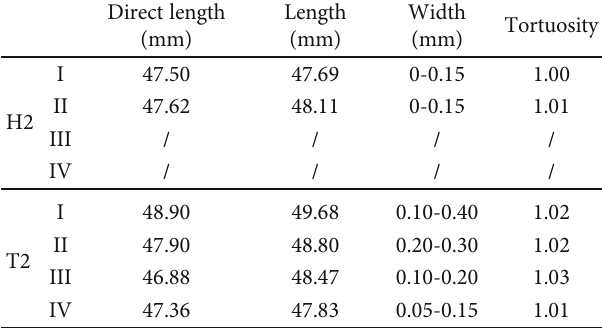
Table 5: Characteristics of visible fractures of rock samples H2 and